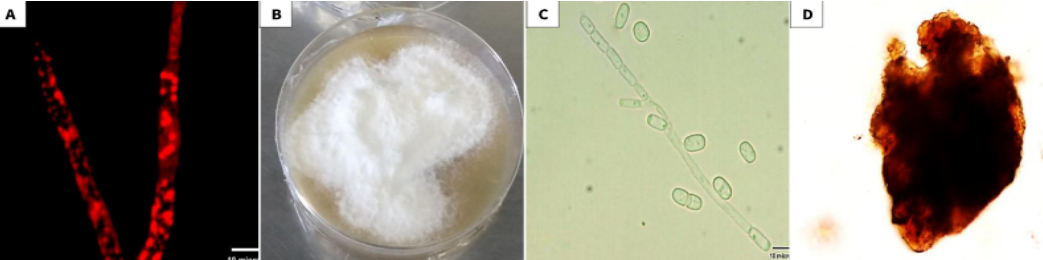
Figure 1. Microscopic and macroscopic features of Arthrographis kalrae . ( A ) Fluorescence microscopic observation of Arthrographis kalrae hyphae stained with Nile red stain marked with intracellular fluorescent red lipid globules. ( B ) Morphological appearance of Arthrographis kalrae. ( C )Asexual morph with poorly branched conidiophore bearing arthroconidia and lateral sessile conidia. ( D ) Sexual morph with dark brown hyphae on the peridium.